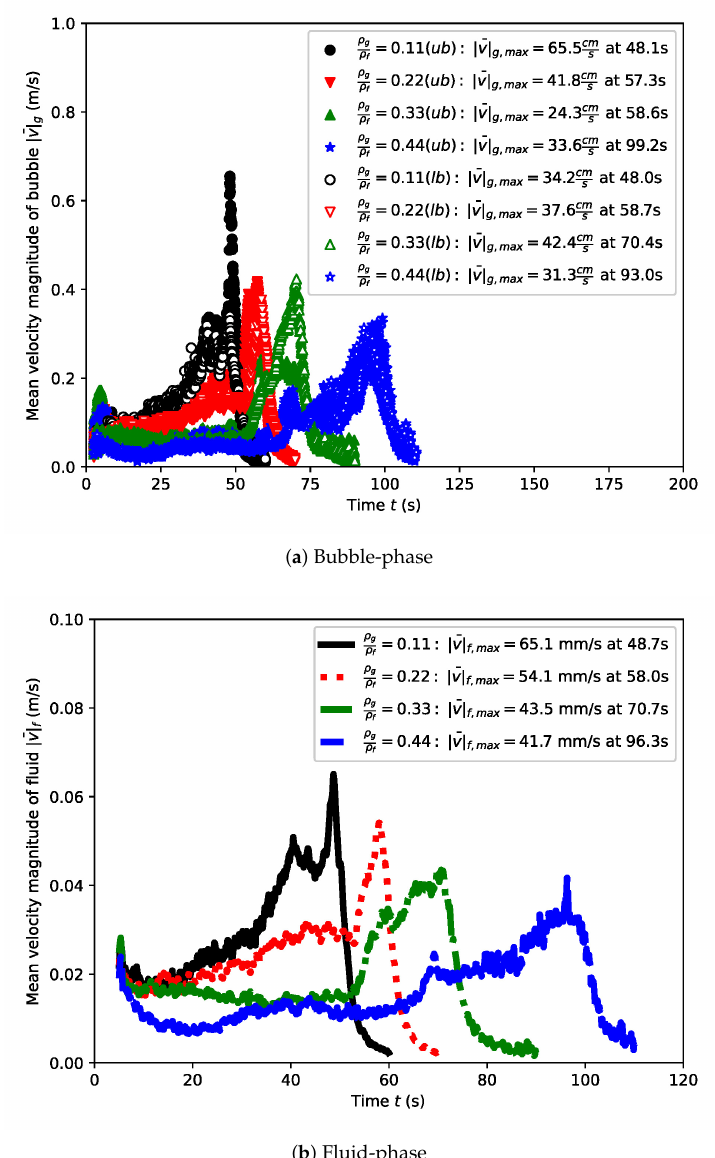
Figure 13. The mean magnitudes of velocities of the bubble ¯ | v | ( b ) for different density ratios ρ g